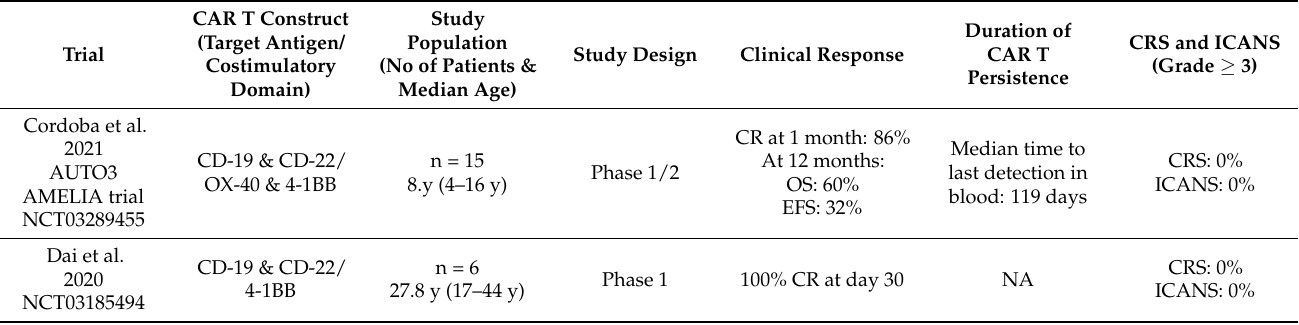
Table 3. Summary of clinical trials of bispecific chimeric antigen receptor T-cell therapy for acute lymphoblastic leukemia